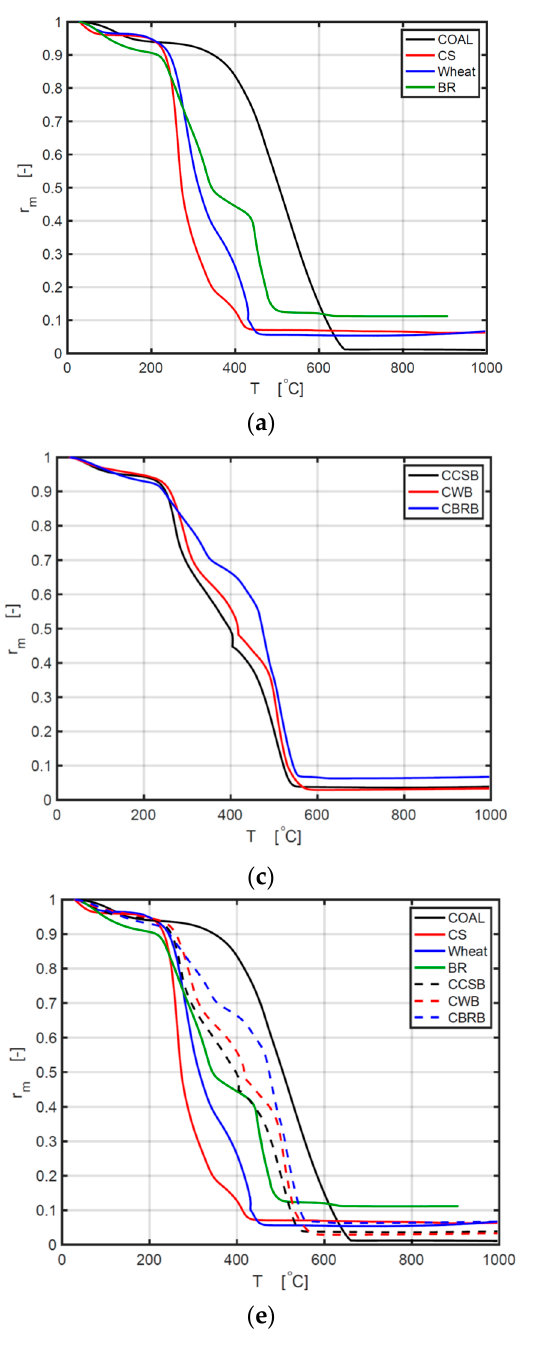
Figure 3. Comparative curves of TG and DTG between different samples under 10 °C/min: ( a ) comparison of TG curves between coal and biomass; ( b ) comparison of DTG curves between coal and biomass; ( c ) comparison of TG curves between different CBBs; ( d ) comparison of DTG curves between different CBB; ( e ) comparison of TG curves between all samples; ( f ) comparison of DTG curves between all samples.